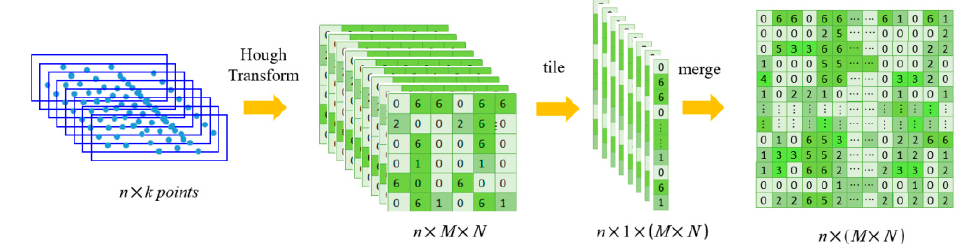
Figure 5. The 2D local feature generation process from the critical points’ neighbors.